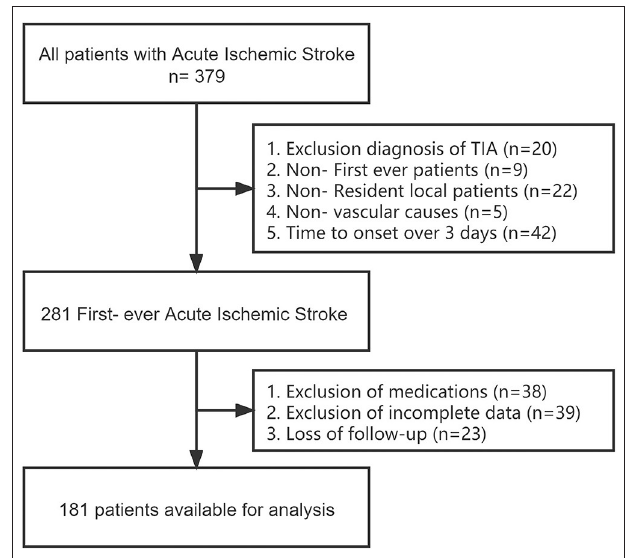
FIGURE 1 | Flowchart of participants’